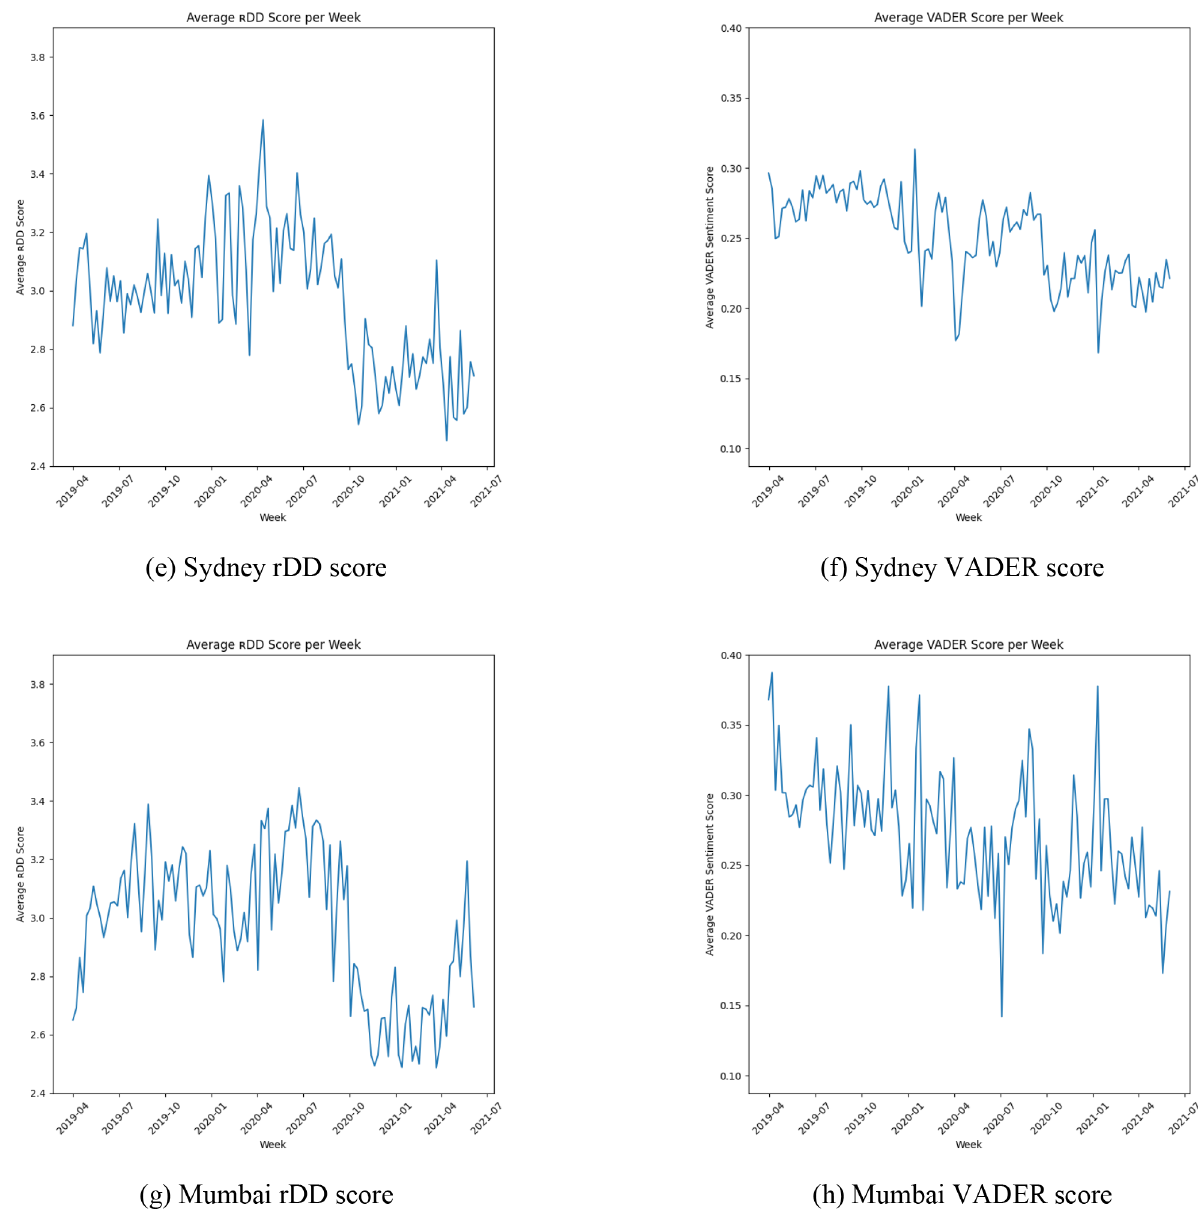
Figure 4: rDD and VADER Scores for Sydney and